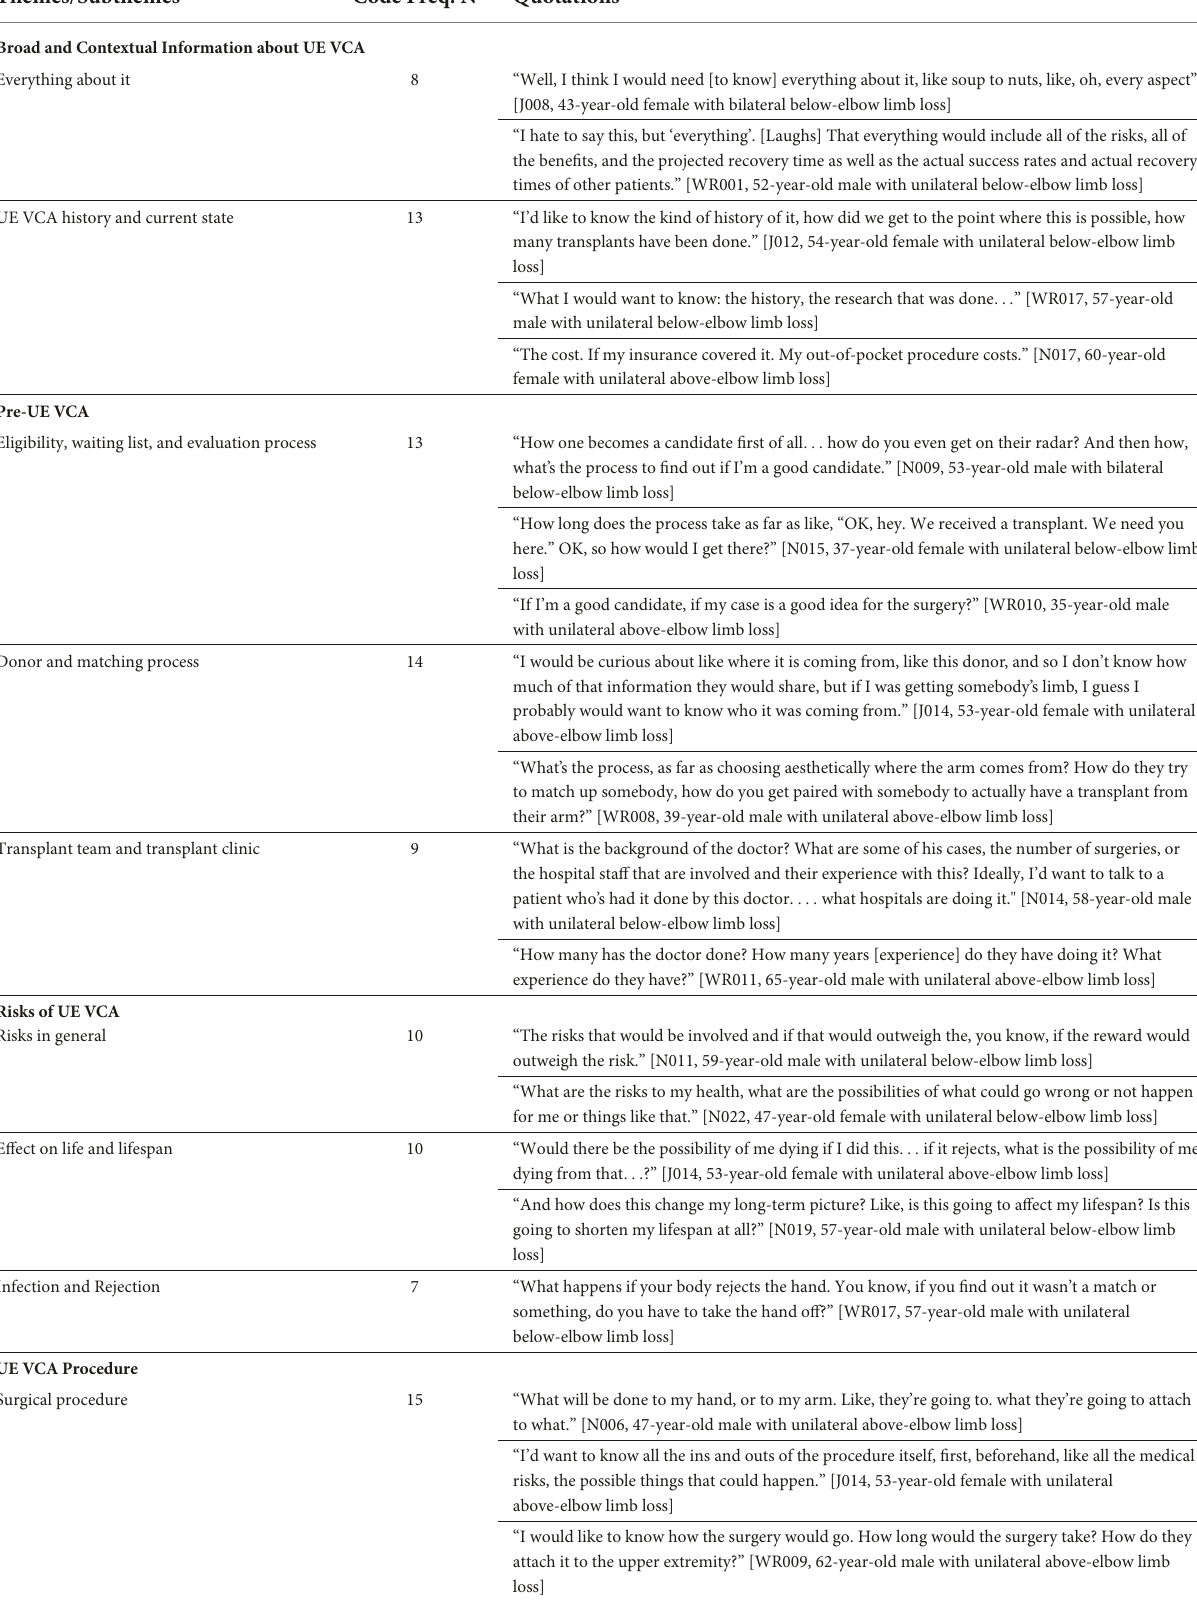
TABLE 2 Representative illustrative quotations about information needs by major theme and subtheme, with code frequency. Themes/Subthemes Code Freq.